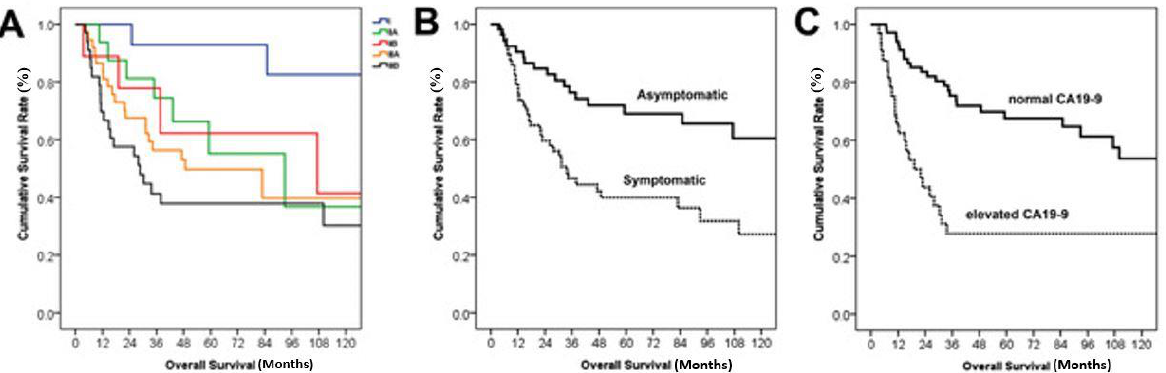
Figure 3. Kaplan–Meier survival curves of survival comparison according to TNM staging, symptoms, and levels of CA19-9. ( A ) In survival comparison according to the American Joint Committee of Cancer staging system, p values were 0.04 for I versus IIA, 0.009 for I versus IIIA, and 0.002 for I versus IIIB. The others were not statistically significant. ( B ) The median survival was not reached in asymptomatic patients ( n = 52), and the median survival of symptomatic patients ( n = 57) was 33.7 months ( p = 0.001). ( C ) The median survival was not reached in patients with normal CA19-9, and the median survival of patients with elevated CA19-9 was 19.1 months ( p < 0.001).